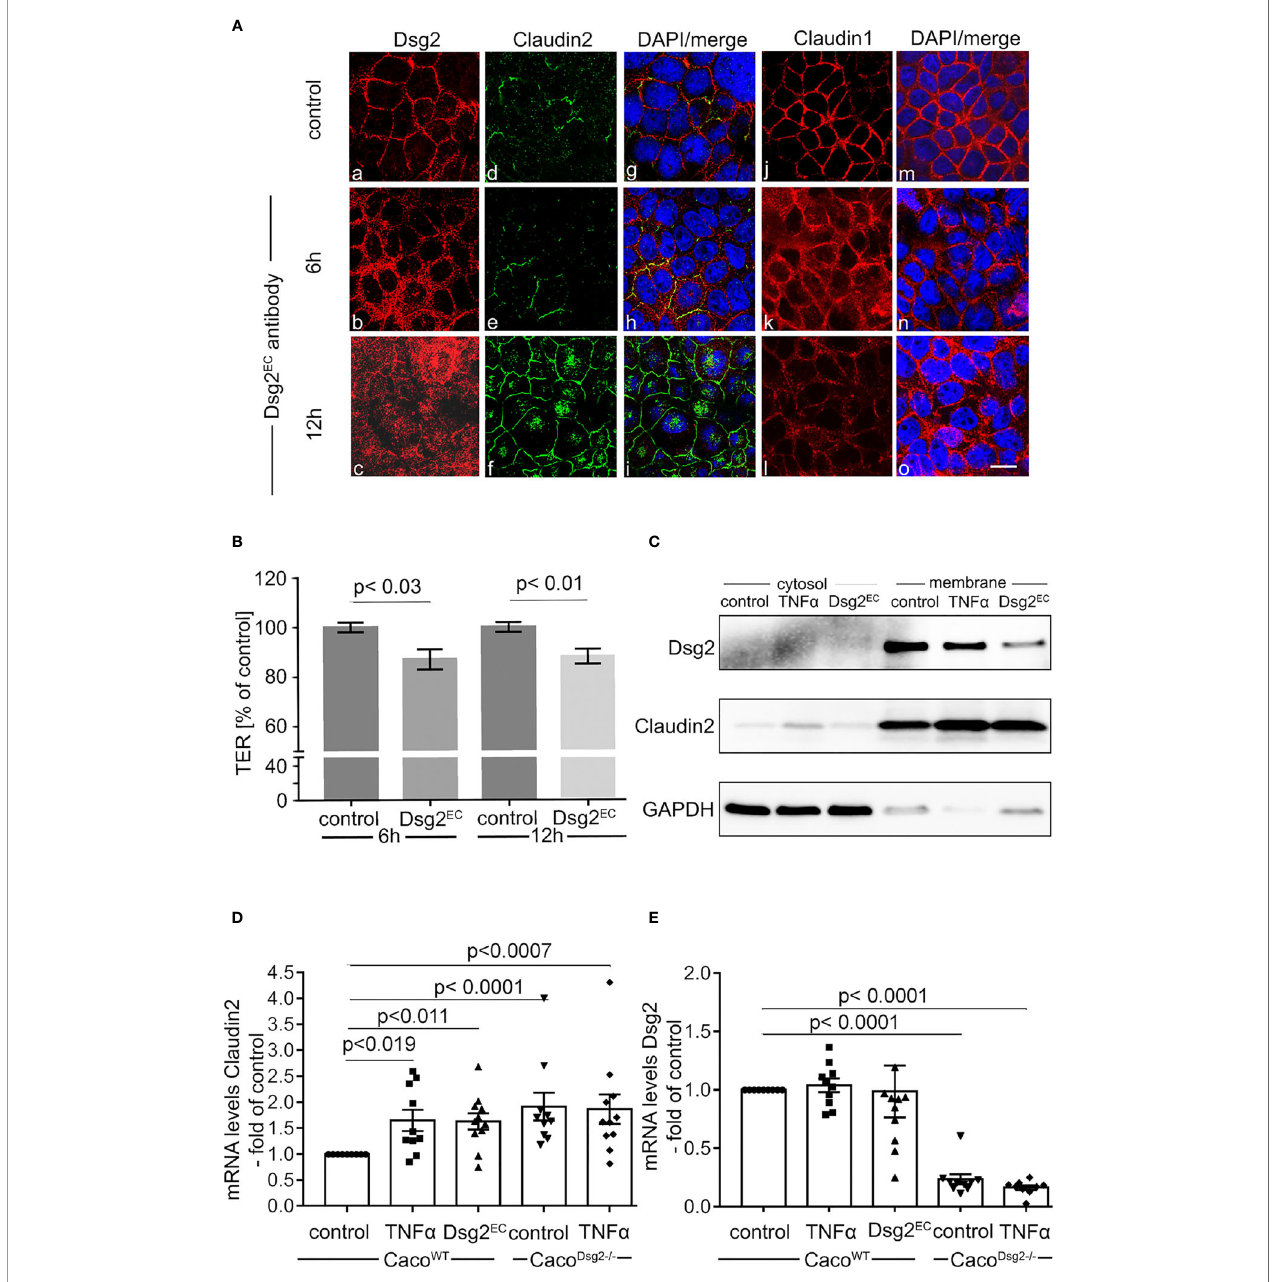
FIGURE 4 | Antibody-induced loss of Dsg2 increased Claudin2 at the cell borders. (A) Immunostaining of Caco2 monolayers for Dsg2 (a-c) Claudin2 (d-f), Claudin1 (j-l) following incubation with a Dsg2 antibody directed against parts of the extracellular domain of Dsg2 (Dsg2 EC; 1:50) for 6h (b, e, h, k, n) and 12h (c, f, i, o) are shown. Application of Dsg2 EC results in loss of Dsg2 at the cell borders (b,c) compared to controls (a). This was paralleled by increased Claudin2 (e,f) whereas changes of Claudin1 staining following Dsg2 EC application are modest (k,l). Images are representative for n=8; scale bar is 20 µm. (B) Application of Dsg2 EC antibody decreases Transepithelial Electrical Resistance (TER) after 6h (p<0.03, n=14, ordinary 1-way ANOVA) and 12h (p<0.01, n=14, ordinary 1-way ANOVA) and 12h compared to untreated CaCo2 cells . (C) Representative Western Blot after cell compartment separation assay is shown for Dsg2 and Claudin2 after incubation of Caco2 with TNF a (24h) or Dsg2 EC (12h). GAPDH served to document the separation in cytosolic and membrane fraction. Both TNF a and Dsg2 EC decrease Dsg2 and augment Claudin2 the membrane-bound fraction; n=5. (D) Quantitative (q)RT-PCR showed that Claudin2 expression was elevated in Dsg2-de fi cient Caco2 cells (Dsg2 -/- ) under basal conditions compared to CaCo2 WT (p<0.0001, n=10, ordinary 1-way ANOVA). Application of TNF a (24h) increased Claudin2 mRNA levels in Caco2 WT compared to untreated cells (p<0.019, n=10, ordinary 1-way ANOVA) but not in CaCo2 Dsg2-/- . (E) qRT-PCR shows that mRNA levels of Dsg2 are not altered following application of Dsg2 EC antibody and no Dsg2 was detectable in Caco2 Dsg2 -/- (n=10, ordinary 1-way